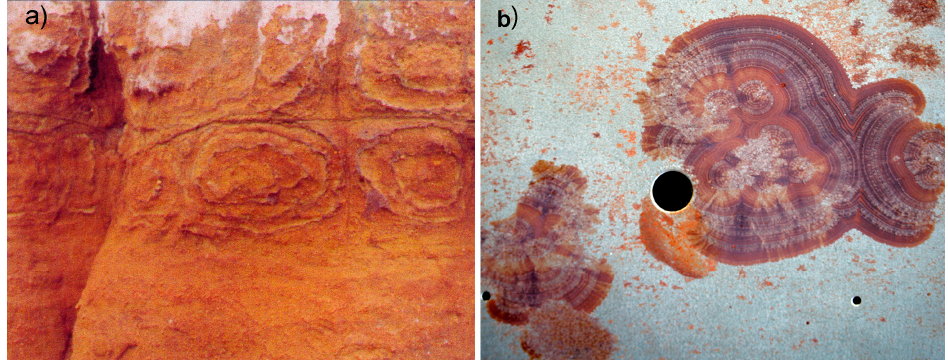
Figure 4. Two natural settings that have developed Liesegang rings. ( a ) An elliptical development in the sandstone cliffs at Hunstanton, Norfolk, England. ( b ) Rust rings that have formed on the support plate of a battery driven clock.